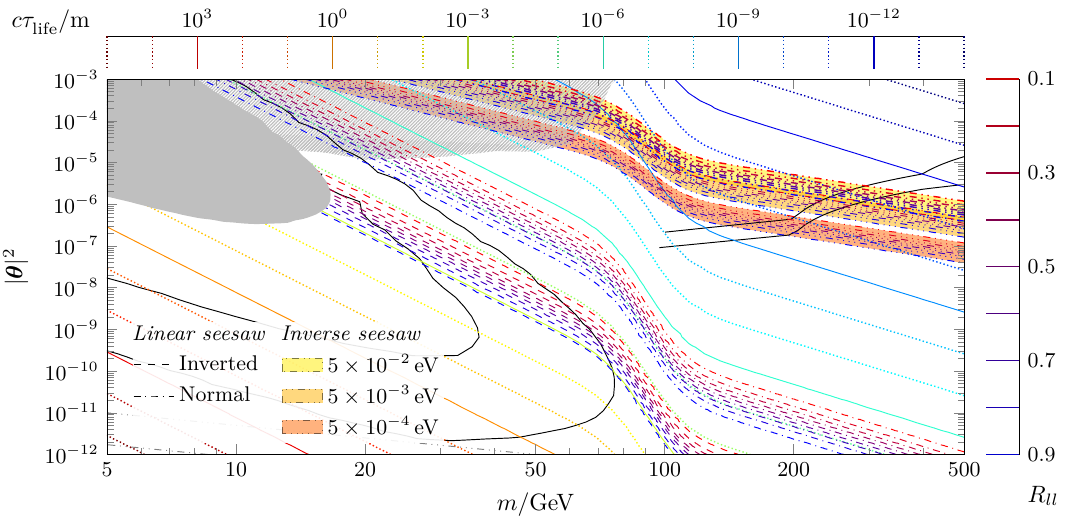
in m overlayed by contour Figure 18 . Contour lines for the heavy neutrino mean lifetime cτ life bands of R ll [0 . 1 , 0 . 9] for the BMs summarised in table 1 . While the two bands generated by the ∈ linear seesaw are well separated and reach far below the W mass threshold, the bands generated by the inverse seesaw are very close to each other and only reach below the W threshold for comparably small values of the active-sterile mixing parameter. For comparison, the regions excluded by the ATLAS and CMS experiments via displaced searches are shown as grey areas [ 51 , 52 ]. The areas shaded in grey at the centre top are excluded by prompt searches [ 53 , 54 ], as long as the prompt same-sign dilepton signature is valid. This is the case only for seesaw models in which R ll is close to one in this region, hence to the bottom left of the R ll bands of the BM under consideration. The reach of the HL-LHC [ 55 ], FCC- ee [ 56 , 57 ], large hadron electron collider (LH e C) and FCC- eh [ 58 ] are shown as black lines. When producing the figure, we have neglected potential effects from a nonzero damping factor λ as well as from times shorter than the Jacob-Sachs threshold; for details, see sections 3 . 1 and 5 . 2